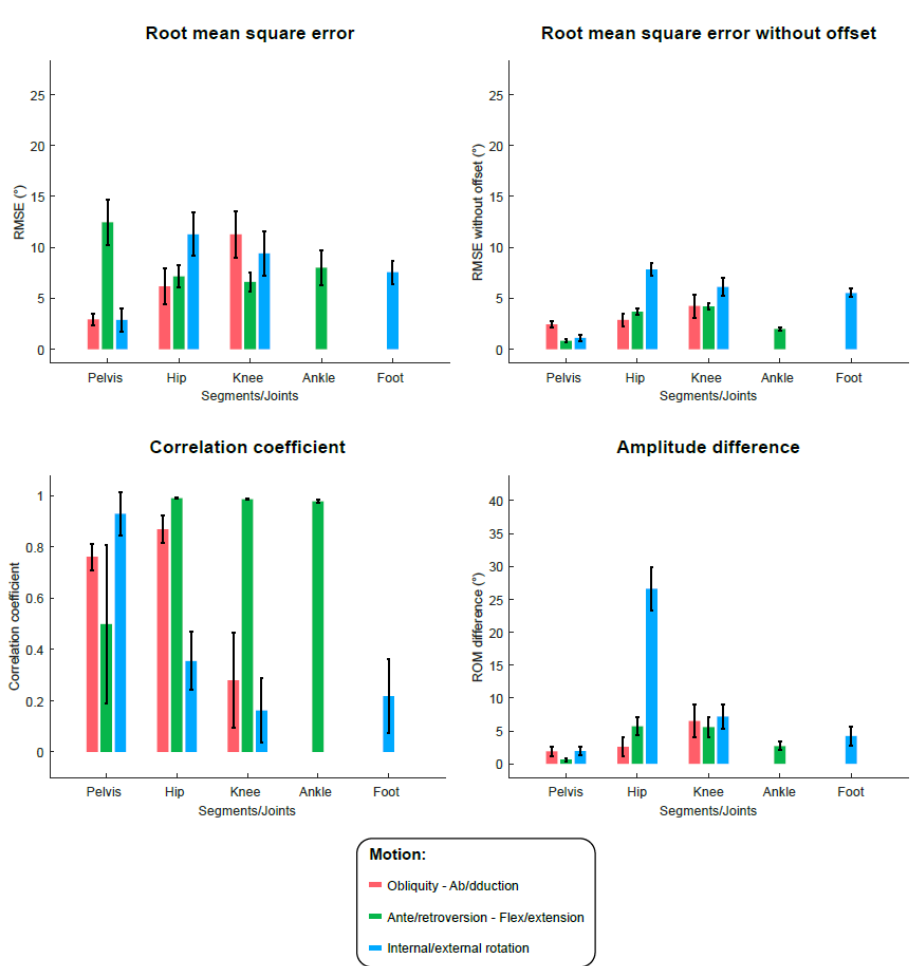
Figure 7. Metrics (root mean square error (RMSE), RMSE centered at the mean, correlation coefficient and difference in range of motion (ROM)) of validity evaluation of the method applied to the cluster data against the optoelectronic reference. Histograms represent the mean values (and interval confidence bars) for all participants, for each joint/segment and each plane.